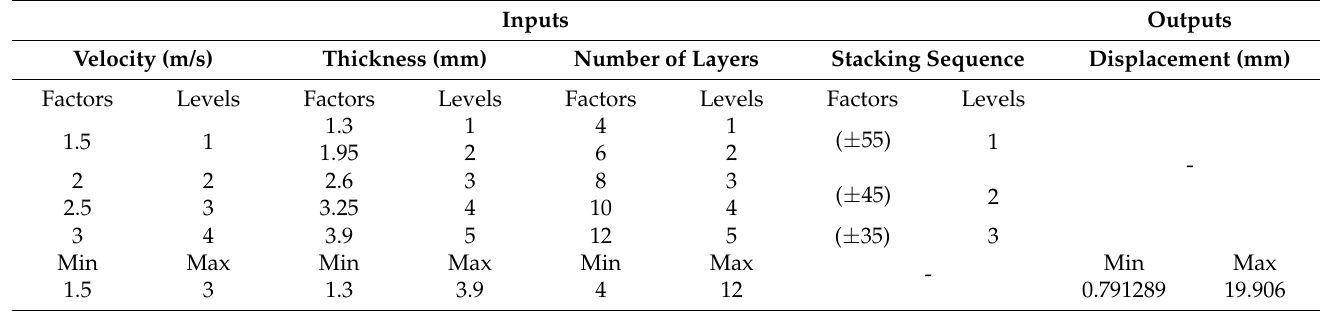
Table 3. The obtained collected data from a developed numerical model used for training ANN-Jaya and ANN-E-Jaya. Inputs Outputs Number of Layers Stacking